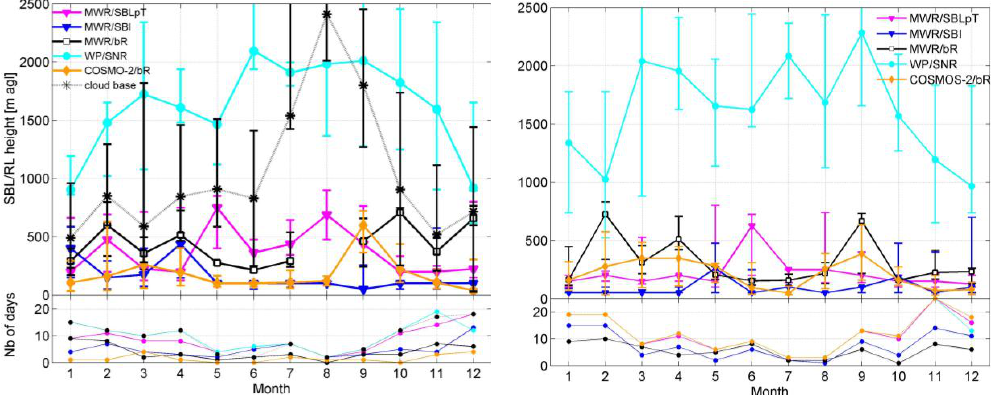
Figure 12. Upper panel: SBL and RL heights for cloudy conditions at PAY (left) and SHA (right). Lower panel: number of cloudy-CBL days used to calculate the monthly medians, the colors correspond to the upper panel ones. Symbols and colors as in Fig. 9. northerly latitude leading to longer summer days and